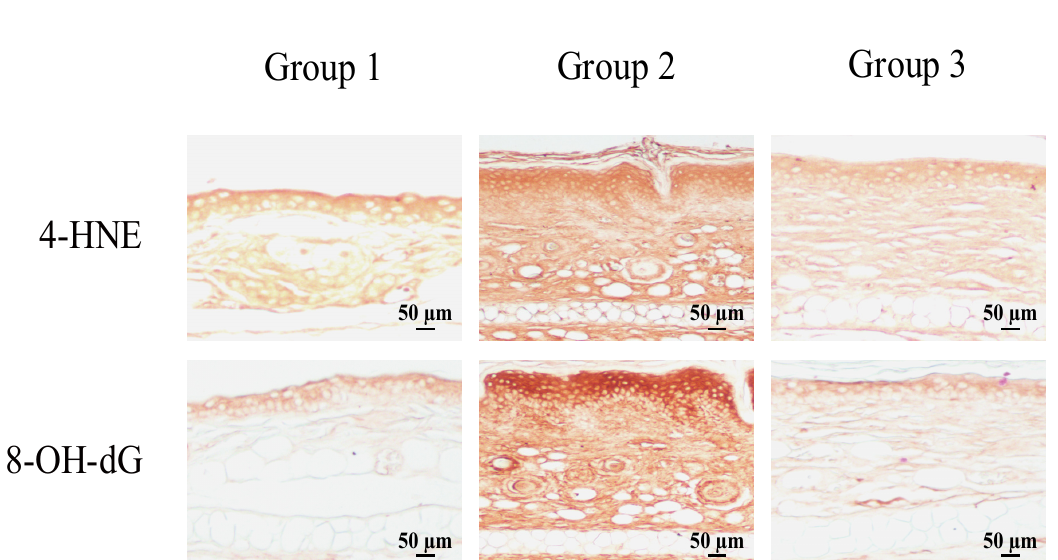
Figure 6. Cardamonin protects against oxazolone-induced oxidative damage in vivo. The formation of oxidative damage markers in mouse skin was visualized by immunohistochemistry using 4-HNE and 8-OH-dG antibodies. A representative slide is provided.